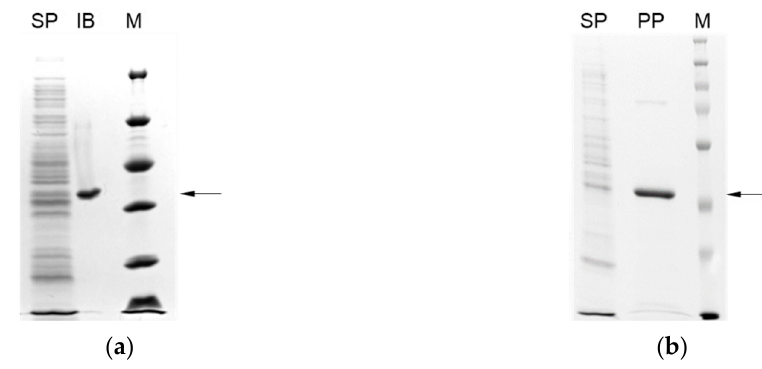
Figure 3. SDS-PAGE gels of Ro GalU1 ( a ) and Ro GalU2 ( b ). Arrows indicate the expected molecular weight of 33 kDa for Ro GalU1 and 34 kDa for Ro GalU2. SP: soluble proteins, IB: inclusion bodies, PP: purified protein, M: Marker.